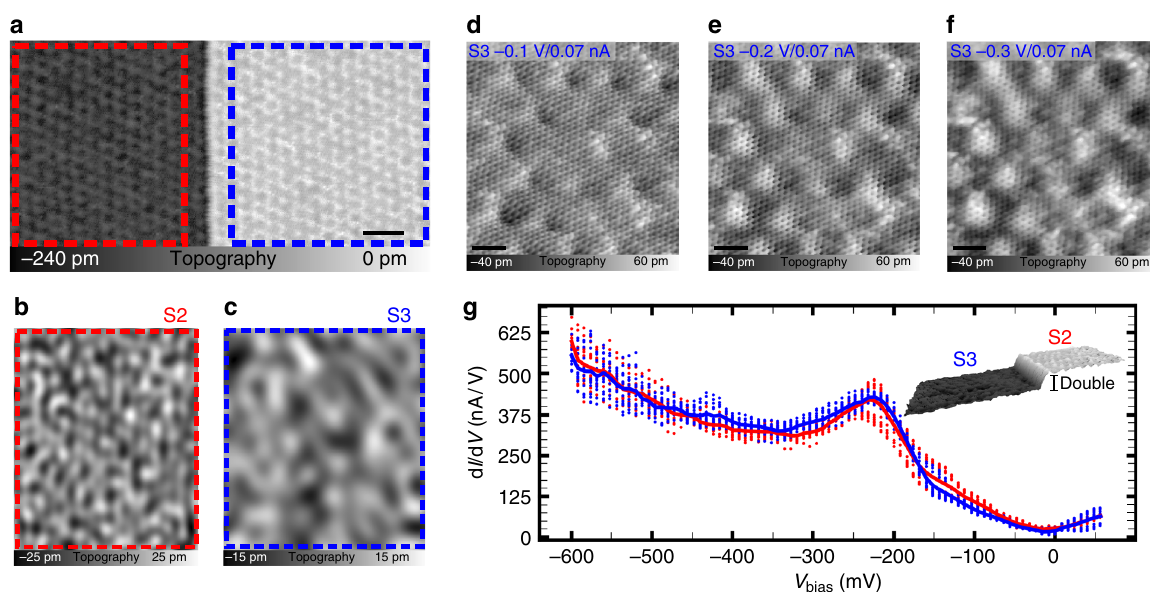
Fig. 4 Analysis of the local defect structure on terraces S2 and S3. a 50 nm × 25 nm constant current topography of terraces connected by a single substrate step. The scale bar is 5 nm. On both terraces the 6 × 6 modulation is well resolved. The topographic contrast is disentangled into its spectral components (as shown in Supplementary Fig. 11) using Fourier analysis. b , c The long-range contributions to the constant current topography are shown for ¼ 0 : 07 nA ) to the left of a double step on a terrace S3 the areas in a marked with dashed red and blue boxes, respectively. d CCT (8 nm × 8 nm, I T ¼ (cid:4) 0 : 1 V , e with a bias voltage of V ¼ (cid:4) 0 : 2 V and f with a bias voltage of V ¼ (cid:4) 0 : 3 V representing the integral acquired with a bias voltage of V Bias Bias Bias eV local density of states in the energy interval E . For d , e , f the scale bar is 1 nm. g Scanning tunneling spectroscopy at 8K on terraces S2 and F ± bias ¼ (cid:4) 0 : 6 V ; I ¼ 0 : 15 nA ð Þ . The solid blue line S3 separated by a double substrate step as indicated in the constant current topography in the inset V Bias T shows the averaging of all spectra recorded on S3 and the solid red line shows the averaging of all spectra recorded on